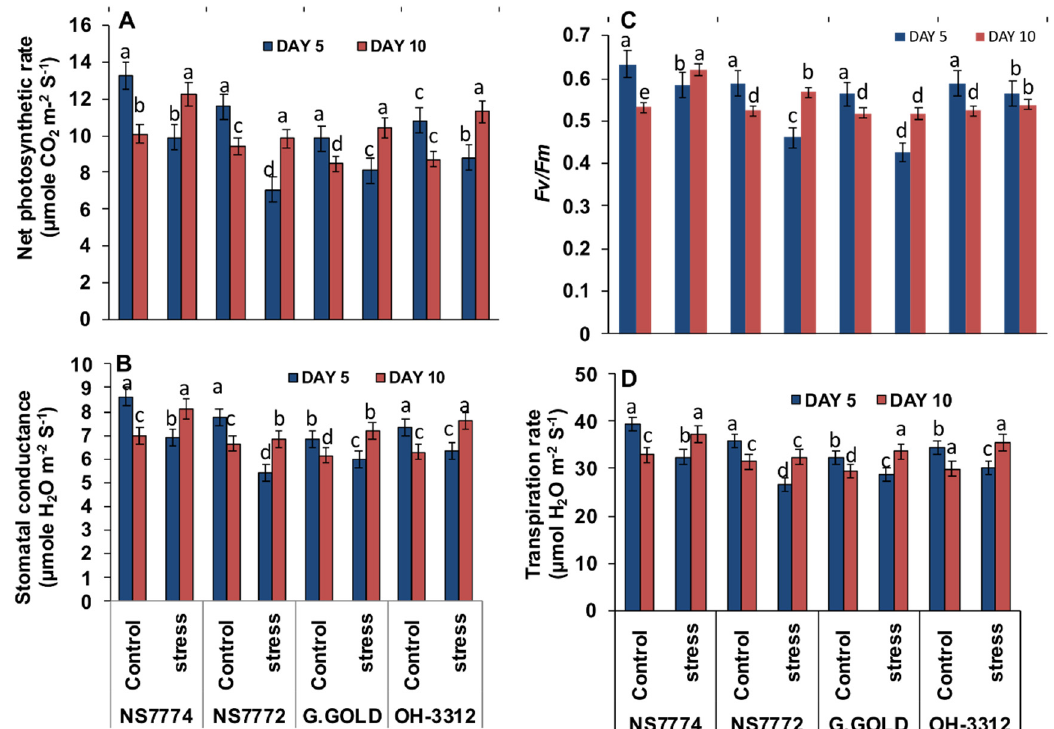
Figure 7. Changes in photosynthetic parameters: ( A ) net photosynthetic rate ( B ) stomatal conductance, ( C ) Fv/Fm, and ( D ) transpiration rate, as affected by drought stress at 5 and 10 days of interval in okra genotypes NS7774, NS7772, Green Gold, and OH3312, along with respective controls. Vertical bars indicate mean ± SE for n = 5. Means denoted by the different letter are significantly different at p ≤ 0.05 according to the Tukey’s studentized range test.